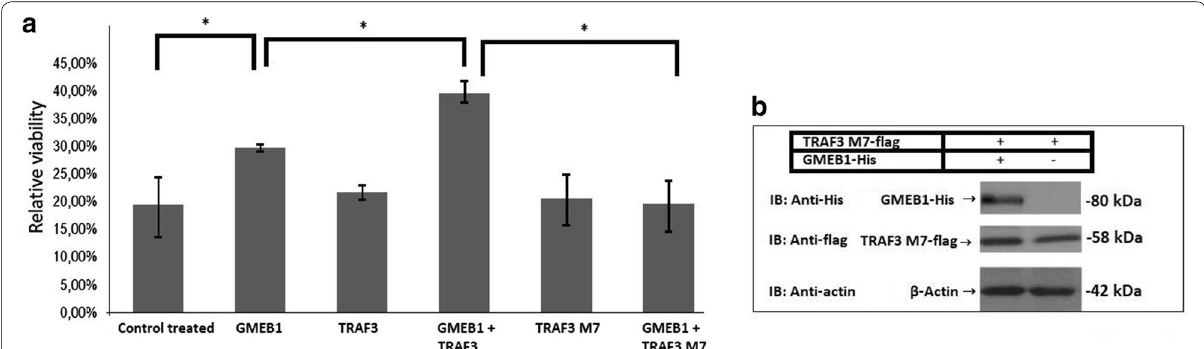
Fig. 3 The effect of TRAF3 on GMEB1-mediated antiapoptotic function. a Assessment of viability of HeLa cells treated by CHX and TNFα, using MTT assay. TRAF3 or TRAF3 M7 (0.5 μg) and GMEB1 (1 μg) expressing vectors were cotransfected to HeLa cells. 20 h postransfection, HeLa cells were treated with CHX and TNFα for 24 h, in order to induce apoptosis. Viability is calculated as the ratio of O.D. sample/O.D. control untreated * 100. The data are presented as the mean standard error ( SEM) of three independent repetitions. Statistical evaluation of the differences between ± ± the values was performed by Student’s t-test. Statistically significant differences are indicated by brackets and an asterisk ( p < 0.05). b Immunoblot analysis. Total cell lysates from HeLa cells transfected with the vectors expressing the indicated proteins were analyzed by SDS-PAGE on a 8% gel. The detection of a catalytically inactive mutant (TRAF3 M7-flag) and the GMEB1-His was performed using the antibodies that are reported in “Methods” section. β-actin was used as a loading